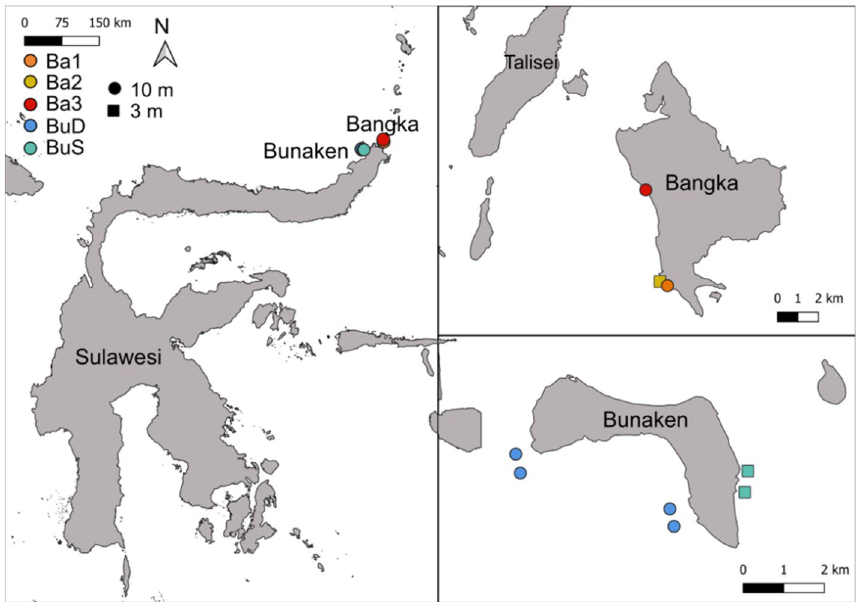
Figure 1. Map of the sites monitored around Bangka and Bunaken Islands (North Sulawesi, Indonesia). Colours indicate the different regimes identified. This map was created using QGIS software (QGIS.org, 2021. QGIS Geographic Information System. QGIS Association. http:// www. qgis.